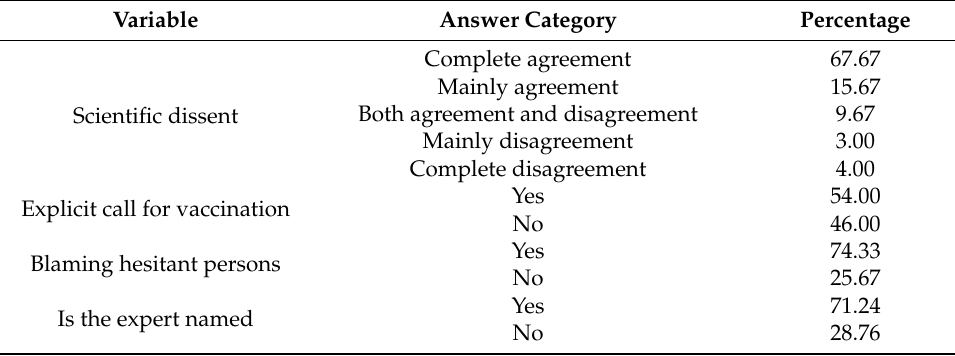
Table 3. Descriptive statistics for the characteristics of the issue